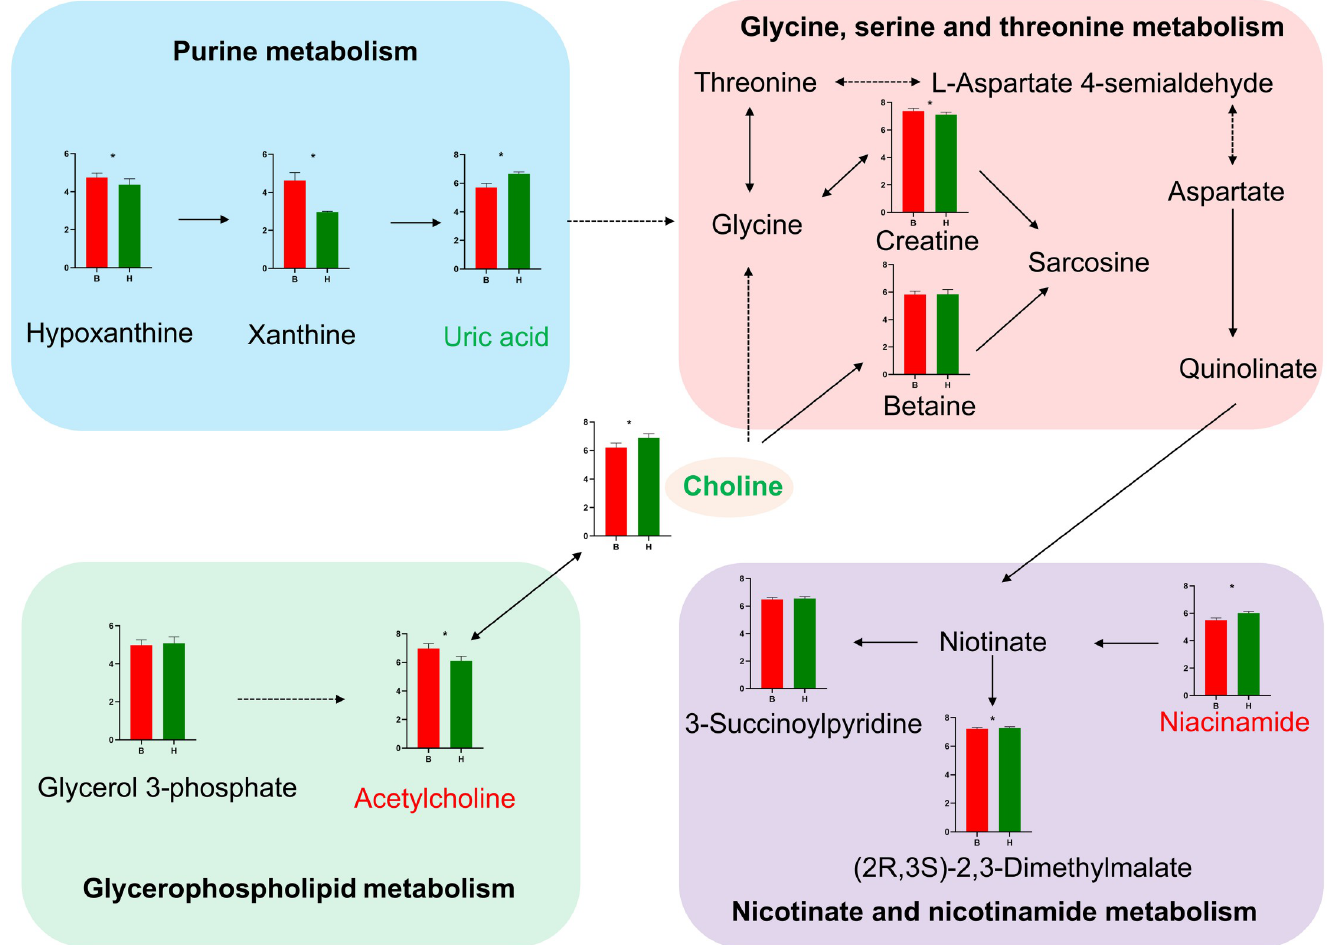
Fig 4. Hypothesized pathway map of the different milk performance between Italian Mediterranean buffaloes (red histograms) and Chinese Holstein cows (green histograms). Metabolites with bars were identified in current study, among them, � Asterisks represent metabolites those significantly different between two groups with p < 0.05; Up-regulated and down-regulated metabolites screened by selection criteria are also indicated in red or green font, metabolites with black font were with VIP < 1. Four metabolic pathways are shown in boxes. The dotted line represents the indirect regulatory relationship and the solid line represents the direct regulatory relationship. Additionally, in the histogram, red on the x-axis represents Italian Mediterranean buffaloes, whereas green represents Chinese Holstein cows. The y-axis stands for the relative concentration of metabolites between the two groups.